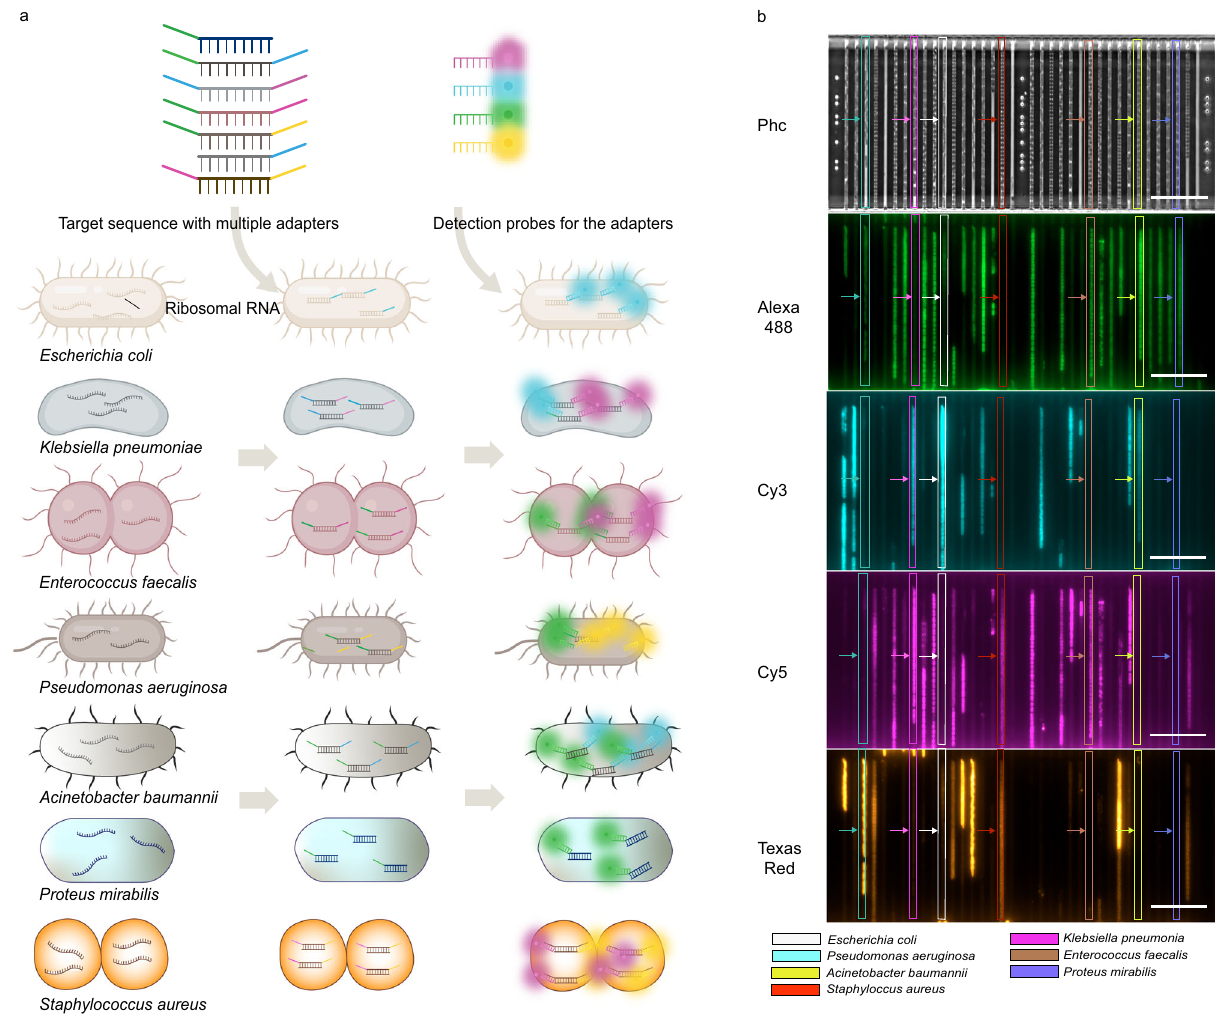
Fig.4 |CombinatorialFISH.a OverviewofthecombinatorialFISHprobing forthe multi species identi fi cation. A cartoon illustrating the different bacterial species with their ribosomal RNA (left). Illustration of the speci fi c sequences with the multiple adapters targeting the ribosomal RNA of individual bacteria and its hybridization to the target rRNA (middle). Detection probes with different fl uor- ophores. Hybridization of detection probes to the adapter sequences along with uniquesequencesthataretargetedtothespeciesspeci fi crRNA(Right). b Example images (Scale bar 20 µ m) of mixed species loaded in the micro fl uidic chip and